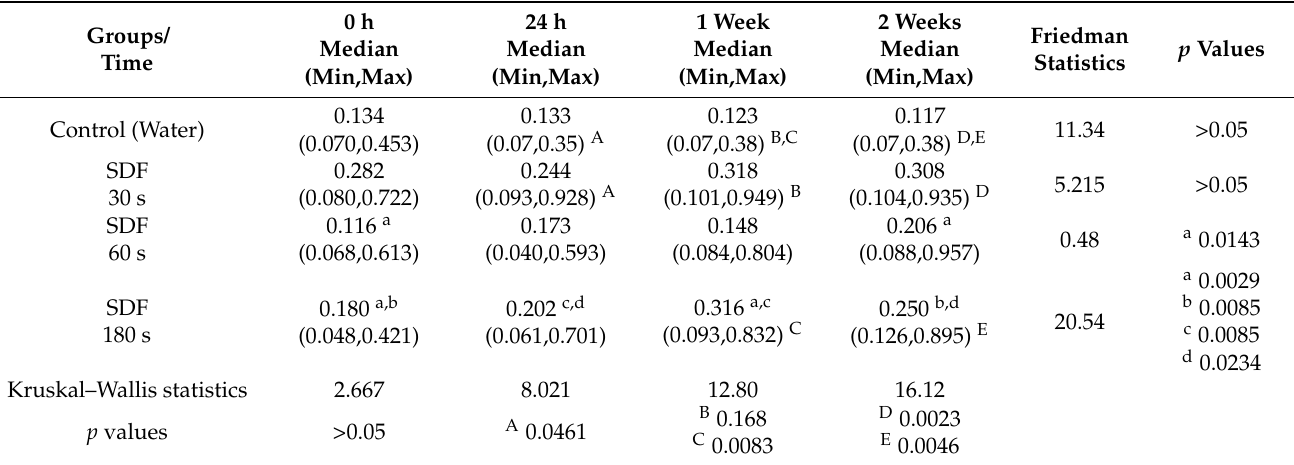
Table 1. The Abs 1024 /Abs 1636 ratios (median, min–max) obtained from specimens in each group for up to 2 weeks ( n = 13). Lower- and uppercase letters within the same row and same column, respectively, indicate significant differences ( p < 0.05).